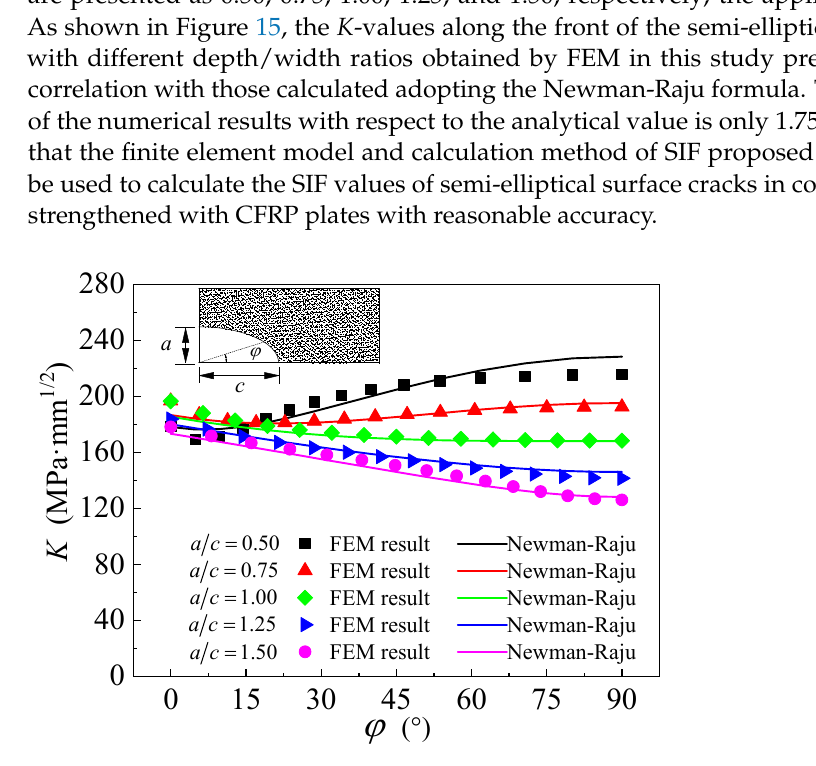
Figure 15. Comparison of K ‐ values obtained by FEM and calculated adopting Newman ‐ Raju for ‐ mula.